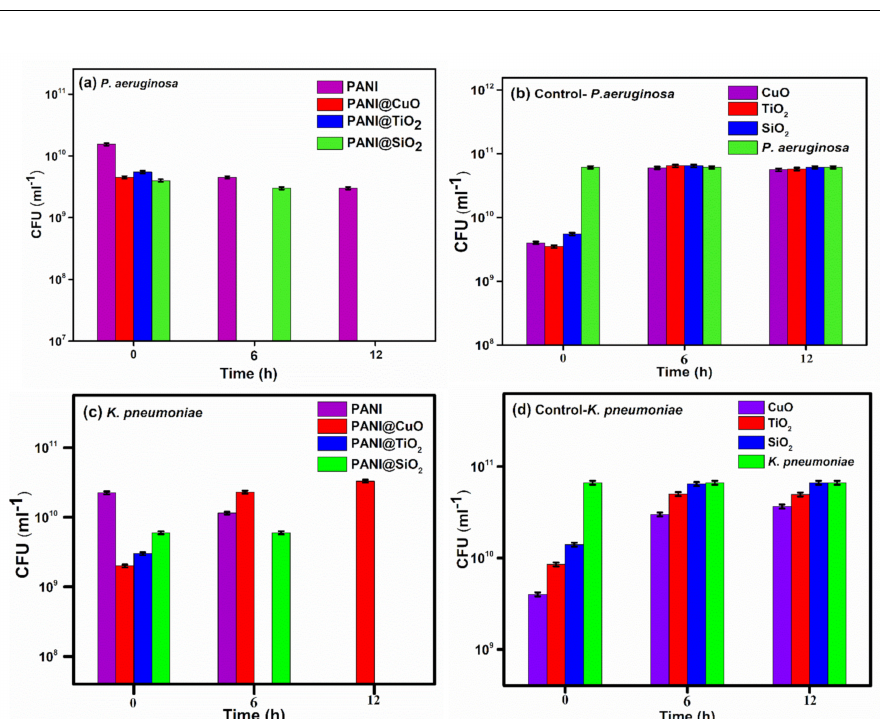
Figure 3. The bactericidal effect of PANI-CuO, PANI-TiO 2 , PANI-SiO 2 on the growth of P. aeruginosa ( a ) and K. pneumoniae ( c ) and the effects of CuO, TiO 2 , and SiO 2 on P. aeruginosa ( b ) and K. pneumoniae ( d ) (Reprinted from Ref.